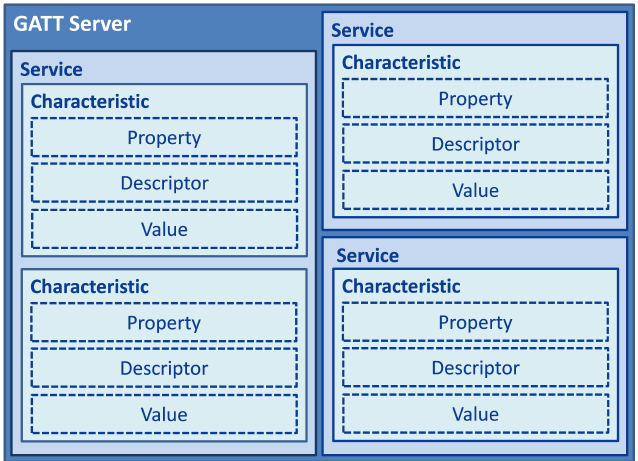
Figure 4. GATT data hierarchy. Immediately before the connection, the GATT server exposes its